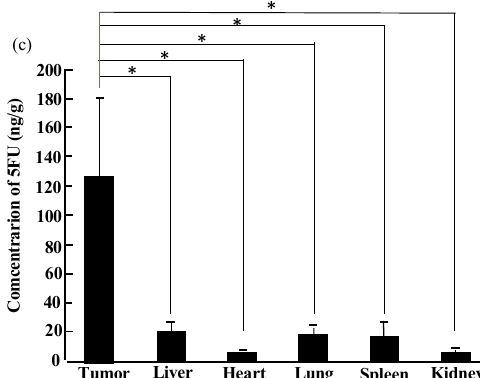
Figure 2. Anti-tumor effects of i.v. injected cytosine deaminase of Escherichia coli (e-CD)-transformed Bifidobacterium longum ( B. longum/e-CD ) combined with oral 5-fluorocytosine (5FC). ( a ) Comparison of tumor volumes of non-injected rats ( n = 5) with those of B. longum/e-CD i.v. injected rats ( n = 15). Rats bearing 7,12-dimethylbenz(a)anthracene-induced mammary tumors received i.v. B. longum/e-CD and 500 mg/kg/day 5FC. * p < 0.05; ** p < 0.01. ( b ) Anti-tumor assessment of B. longum/e-CD in nude mice transplanted with KPL-1 human mammary tumor cells. Tumor-bearing nude mice ( n = 8) were given a dose of transformed bacteria cells i.v. (5.9 × 10 9 c.f.u./mouse), followed by oral 5FC for 21 days. ( c ) Measurement of 5-fluorouracil (5FU) concentration in various tissues in rats bearing MRMT-1 mammary gland carcinoma. Rats were given B. longum/e-CD at 1.1 × 10 10 c.f.u./rat i.v. and 5FC by intragastric gavage for 4 days starting on day 4 after bacterium injection. The concentration of 5FU in normal tissues and tumor tissues was measured. Rats given 5FC without injection of B.